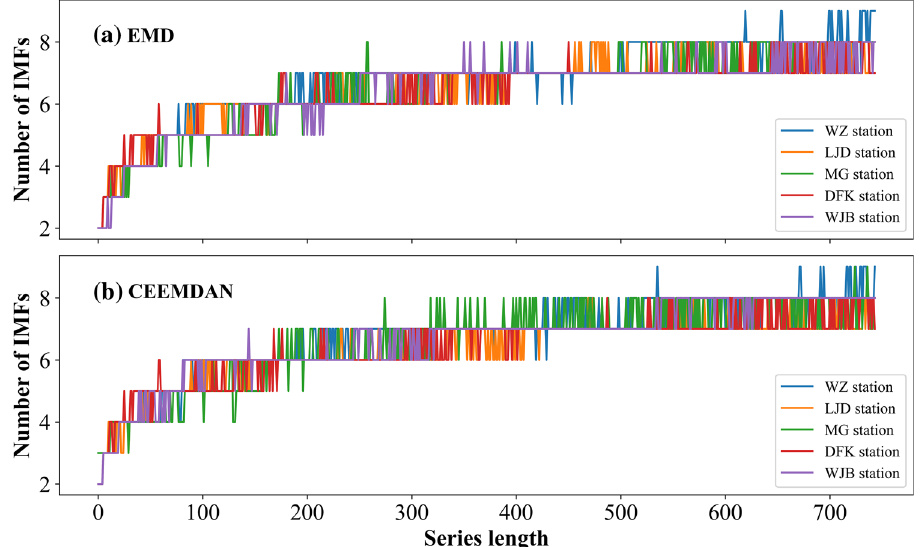
Fig. 8 Relationship between the number of IMFs and the length of the series decomposed using the a EMD and b